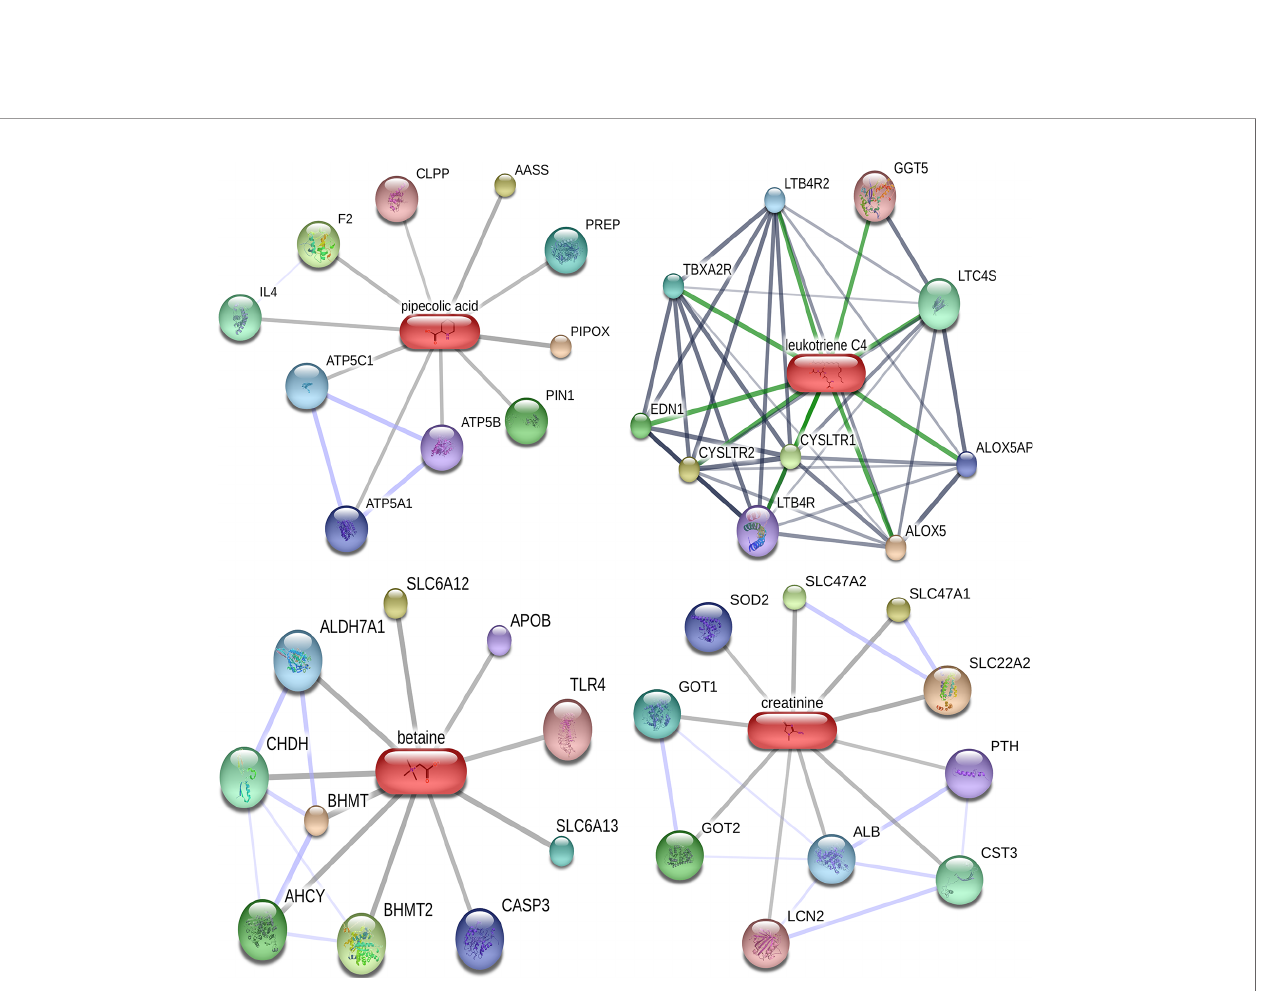
FIGURE 7 | Target molecular network diagram for predicting four signi fi cantly different metabolites in Cytoscape.